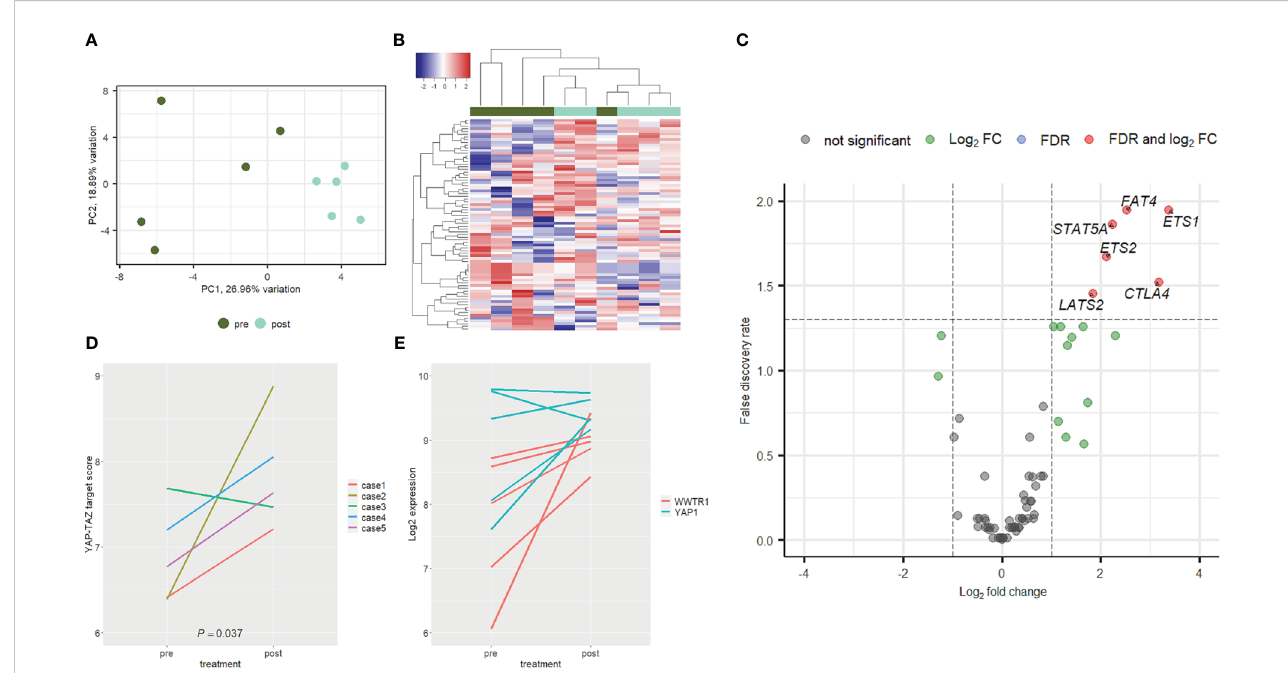
FIGURE 6 Expression pro fi le of Hippo genes. Paired naïve (green) and post-surgical (cyan) tumors from the chemo-immunotherapy cohort clearly separated at PCA (A) and hierarchical clustering (B) analyses. In post-surgical specimens a trend towards gene upregulation was observed (C) , with six genes signi fi cantly deregulated (red dots). YAP-TAZ target score was signi fi cantly upregulated in post-surgical samples (D) . This was consistent with a trend towards upregulation of genes encoding for YAP and TAZ (i.e., YAP1 and WWTR1 respectively, especially the latter) (E)